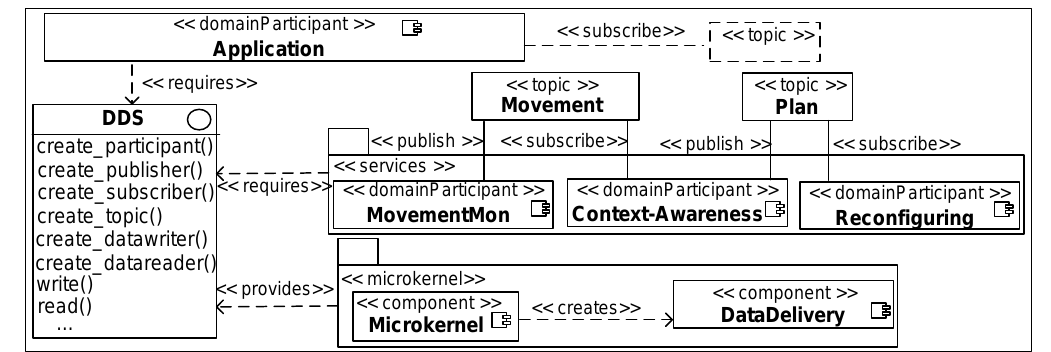
Figure 8. FamiWare autonomic